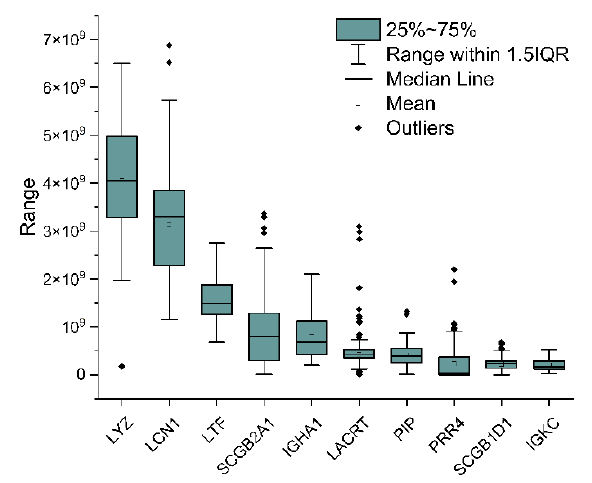
Figure 6. Box plot of the intensity of the 10 most abundant proteins over 70 runs. Each box represents the interquartile range between the 25th and the 75th percentile, whereas the whiskers represent the range between the 5th and the 95th percentile. The median and mean values are also reported, as a line and an empty square, respectively. Outliers are represented by black diamonds. Proteins are indicated by their gene name: LYZ, lysozyme C; LCN1, lipocalin-1; LTF, lactotransferrin; SCGB2A1, mammaglobin-B; IGHA1, immunoglobulin heavy constant alpha 1; LACRT, extracellular glycopro- tein lacritin; PIP, prolactin-inducible protein; PRR2, proline-rich protein 4; SCB1D1, secretoglobin family 1D member 1; IGKC, immunoglobulin kappa constant.